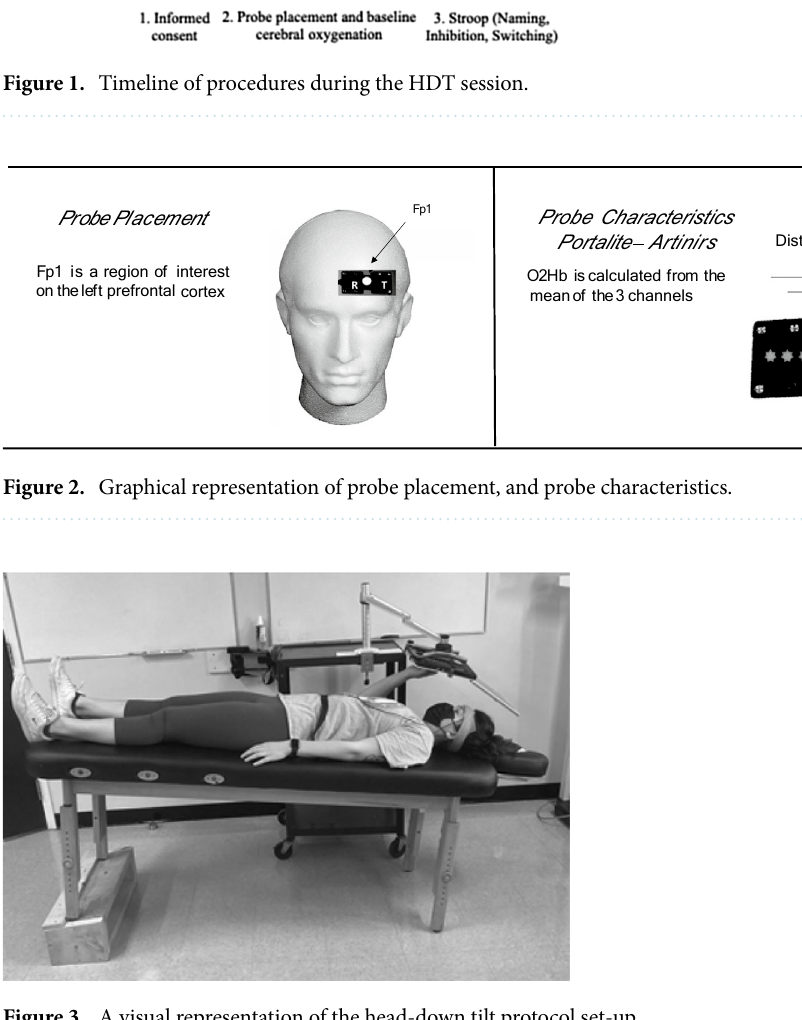
Figure 3. A visual representation of the head-down tilt protocol